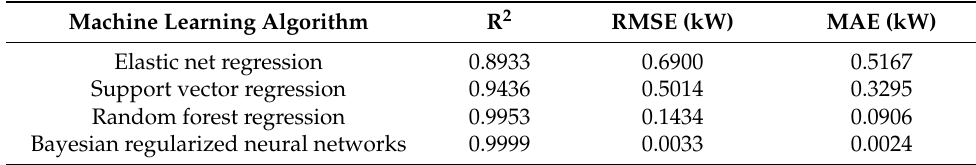
Table 7. Performance metrics—training phase